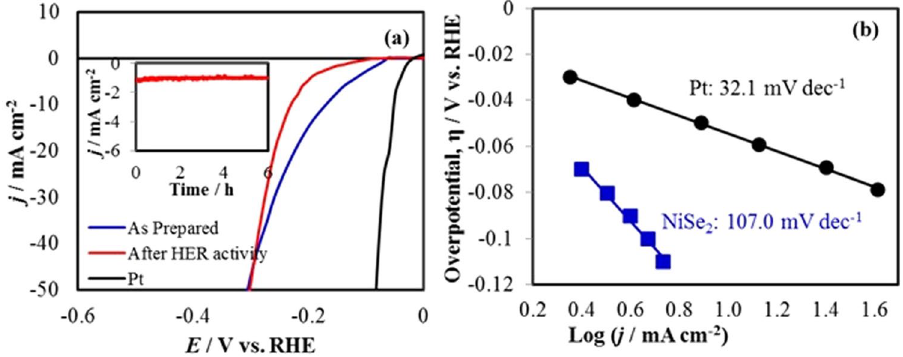
Figure 7. ( a ) LSVs measured at NiSe 2 /Au and Pt in N 2 saturated 1.0 M KOH solution at a scan rate of 0.01 V s − 1 . Inset shows the HER stability of NiSe 2 . ( b ) Tafel plots of catalysts.